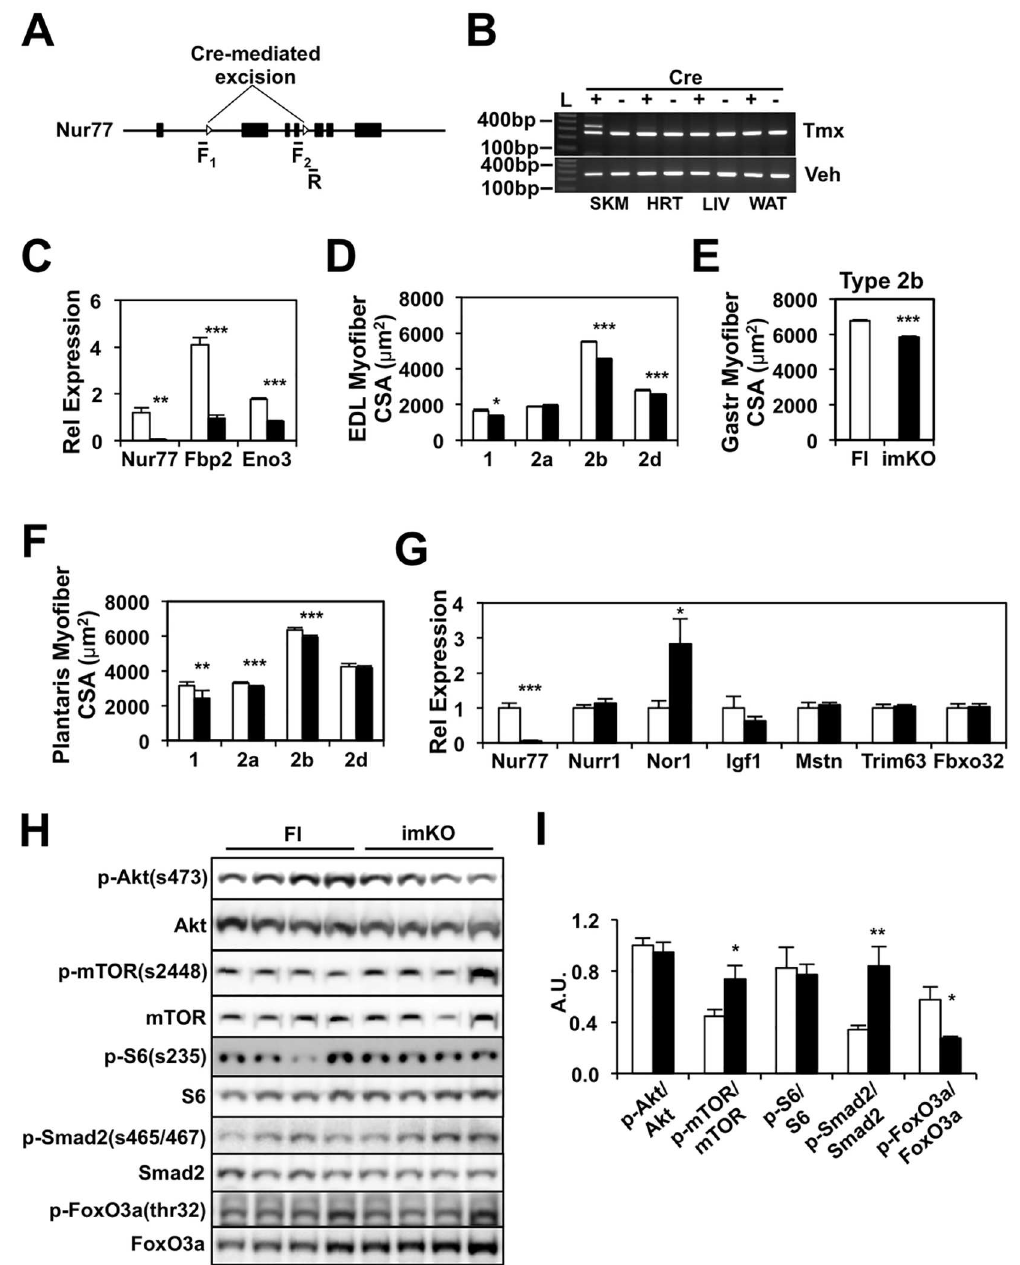
Fig 4. Characterization of the inducible, muscle-specific, Nur77-null (imKO) mouse. (A) Schematic of the floxed-Nur77 allele. Open triangle—LoxP site. F 1 , F 2 , and R denoteforward and reverse genotypingprimers. (B) Confirmation of tamoxifen- and muscle-specific deletionof Nur77 by PCR genotyping. Upper panel—mice injected with tamoxifen (Tmx); lower panel—mice injectedwith vehicle (Veh). L—ladder,SKM—skeletal muscle, HRT— heart, LIV—liver, WAT—white adiposetissue. (C) Expression of Nur77 and its target genesin quadricepsmuscle of control (Fl) and imKO mice one week after tamoxifen injection.N = 4. (D-F) Mean myofiber CSA of EDL, gastrocnemius, and plantarismuscles. N = 6–8. (G) Gene expressionfrom white quadriceps of 6-month-old Fl and imKO mice. (H) Immunoblotanalysisof EDL lysate. (I) Quantitation of immunoblot. N = 7. White bars denotefloxed controls, black bars denote imKO mice. ** P < 0.01, ** P < 0.01, *** P < 0.001.